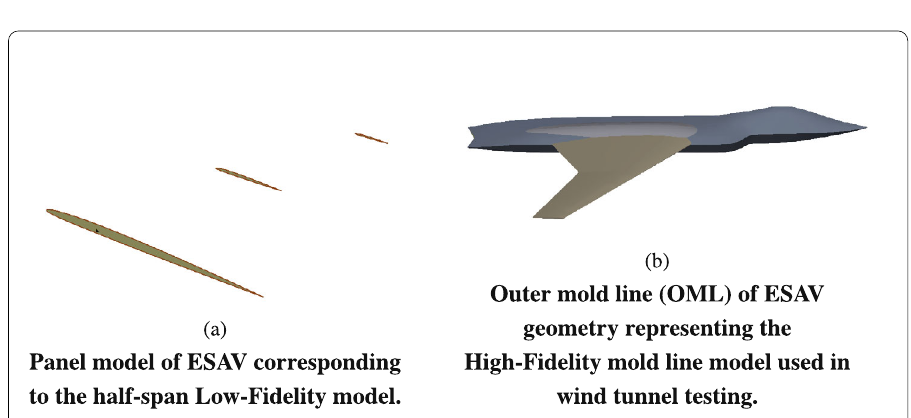
Fig. 3 Illustration of Multi-Fidelity scaling (or corrective) approaches by [75]